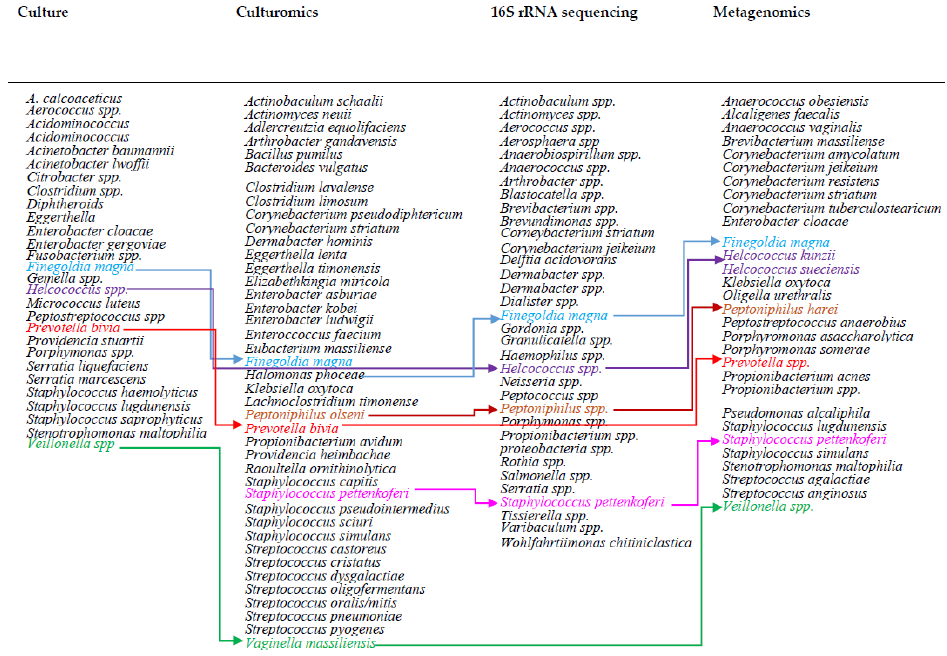
Table 1. Uncommon bacterial species isolated from diabetic ulcers using different bacterial identification